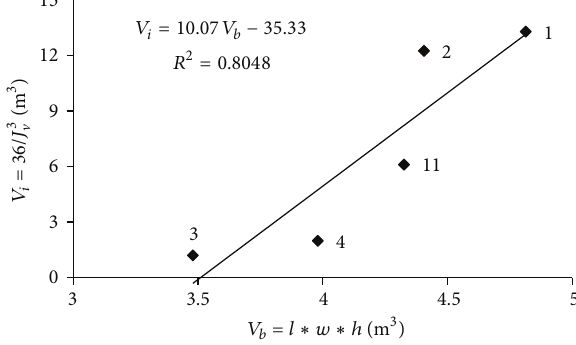
Figure 7: Relationship between the % BQD ratio and the mean volume of the blocks (𝑉 𝑏 ) produced in the Karaburun limestone quarries.